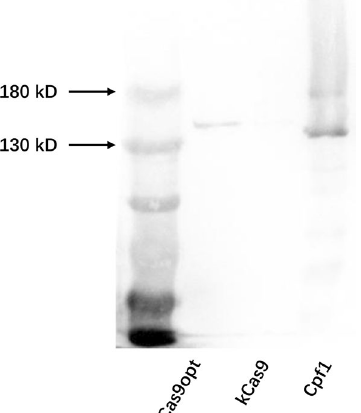
Fig. 2 Western blot analysis of Cas proteins (M, 180 kD protein ladder; Cas9opt, cas9 codon-optimized for A. succinogenes ; kCas9